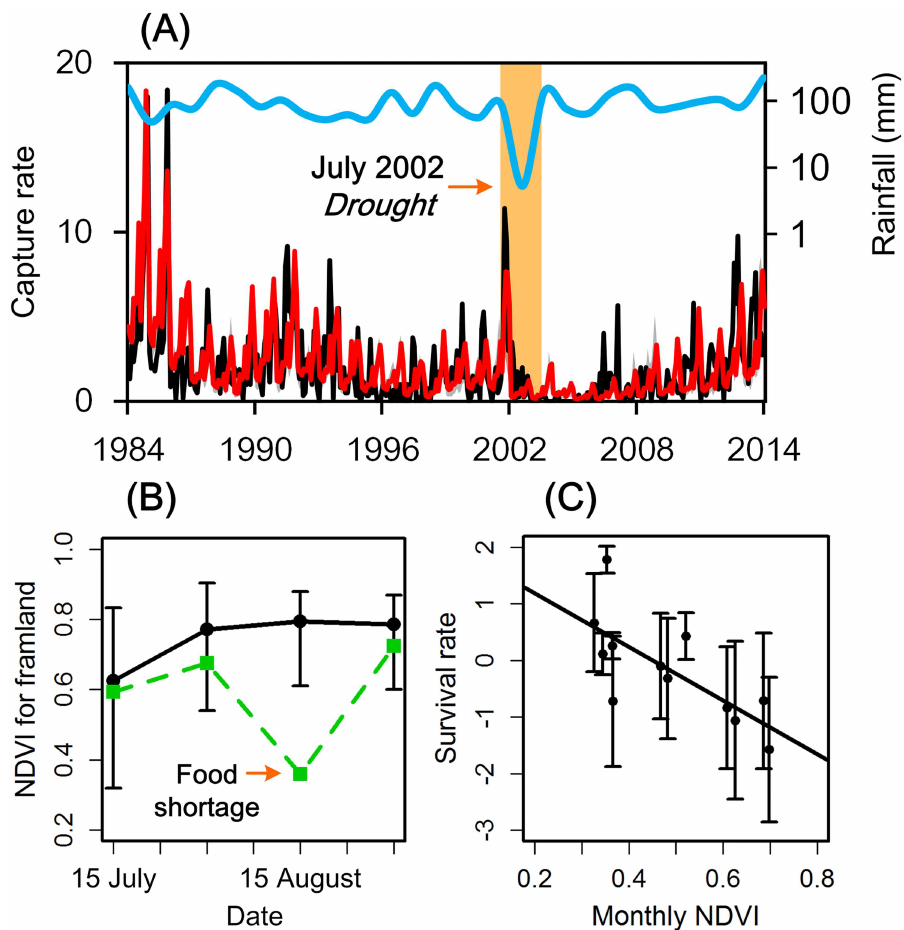
Fig 2. Environmental fluctuations, rodent host dynamics, and hantavirus infections. (A) Rodent population density observed(black line), model-simulated density (red line), and rainfall in July (blue line, unit: mm), 1984–2014. The orange-shaded vertical bars indicateperiods of drought. Model-predicted and observeddensity have a correlation of R = 0.73, P < 0.01. (B) Normalizeddifference vegetationindex values for farmlandduringthe drought, from July to August (green dotted line). The black line indicatesthe average NDVI value of farmlandfrom July to August, 1984–2014. Error bars give ± 2 standarddeviations. (C) The effect of seasonalchangesin NDVI on rodent survival estimated from Eq 2. Error bars show the 95% credible